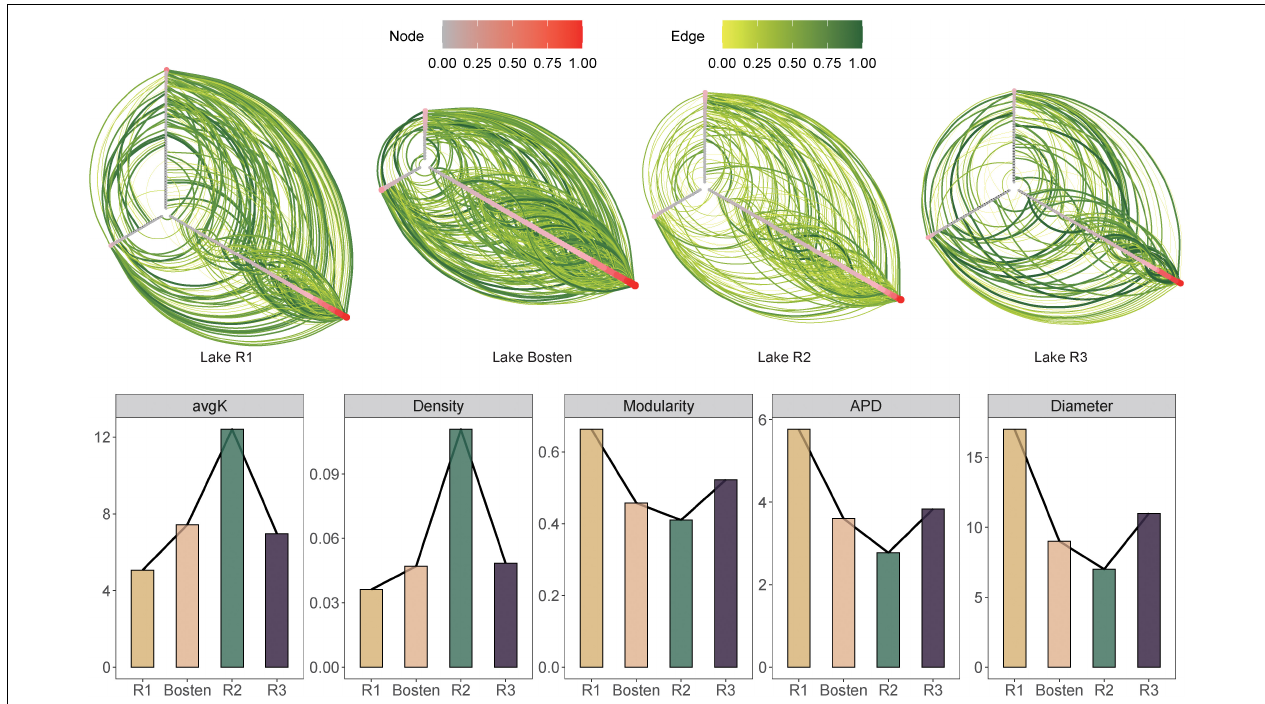
FIGURE 8 | Hive plot of interspecific interactions for the bacterial communities of the four lakes. To visually compare the individual networks, nodes (in red) and weight of edges (in green) were scaled to